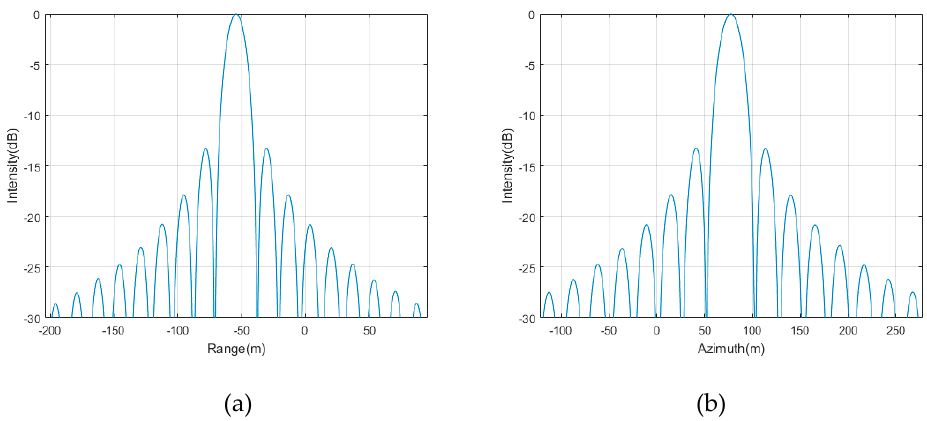
Figure 11. Range profile and azimuth profile of the imaging result: ( a ) the range profile ( b ) the azimuth profile.